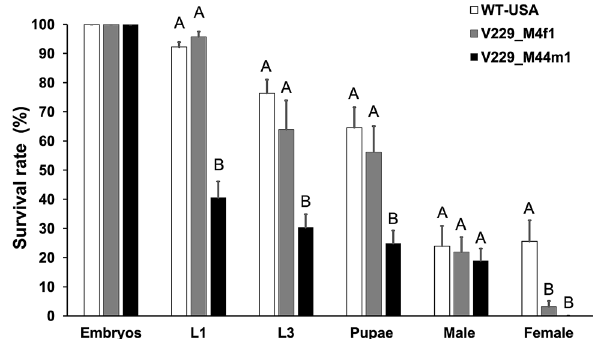
Figure 2. Determination of the lethal stage in transgenic D. suzukii lines. Homozygous males from lines V229_ M4f1 or V229_M44m1 were crossed with wild-type (WT) virgin females on tetracycline-free diet, 500 embryos were collected, and we recorded the numbers of first-instar (L1) and third-instar (L3) larvae, pupae, adult males and adult females. Similar tests were conducted by crossing WT males and females as controls. The survival rate was calculated by dividing the number of flies in the corresponding stage or sex by the number of embryos. Each bar presents the mean ± SE of n = 7 experiments. Different letters indicate significant differences at P < 0.001 (one-way ANOVA, Holm-Šidák method).